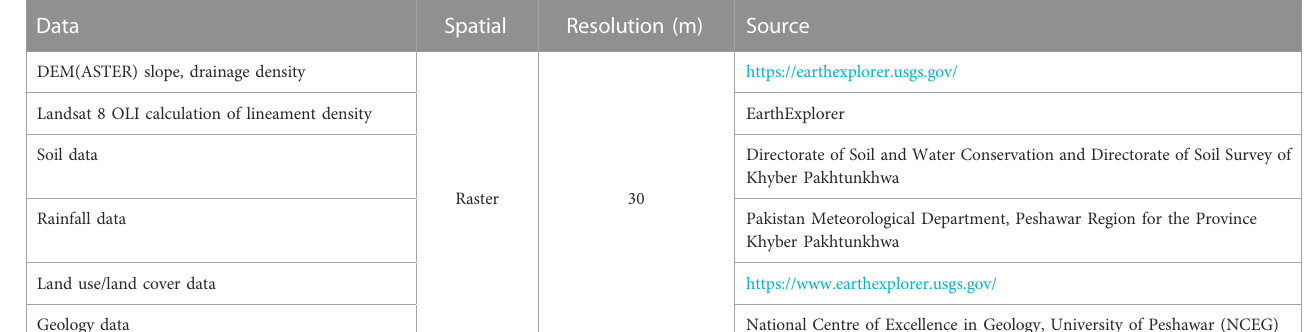
TABLE 1 Dataset source and resolution.